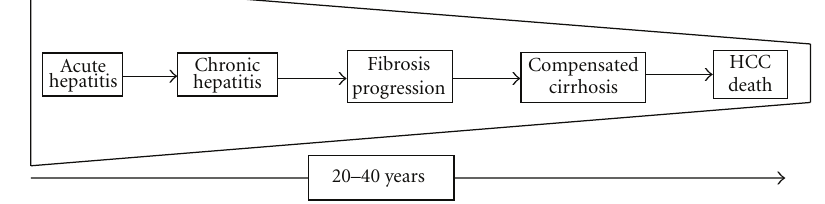
Figure 1: Natural history of chronic HCV